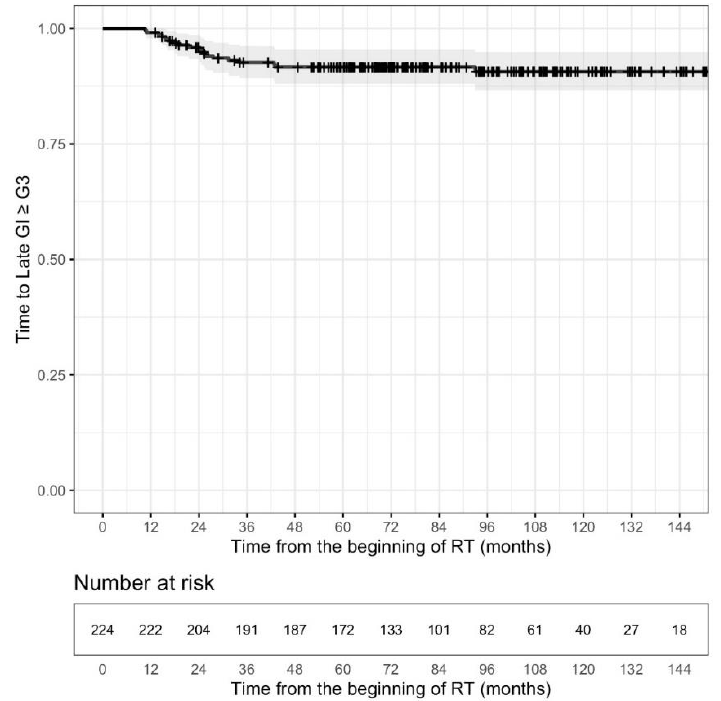
Figure 4. Kaplan–Meier estimate of time to late GI ≥ G3. Although all the data were used for statistical analyses, here, for graphic purposes only, the plot was curtailed at 12 years.